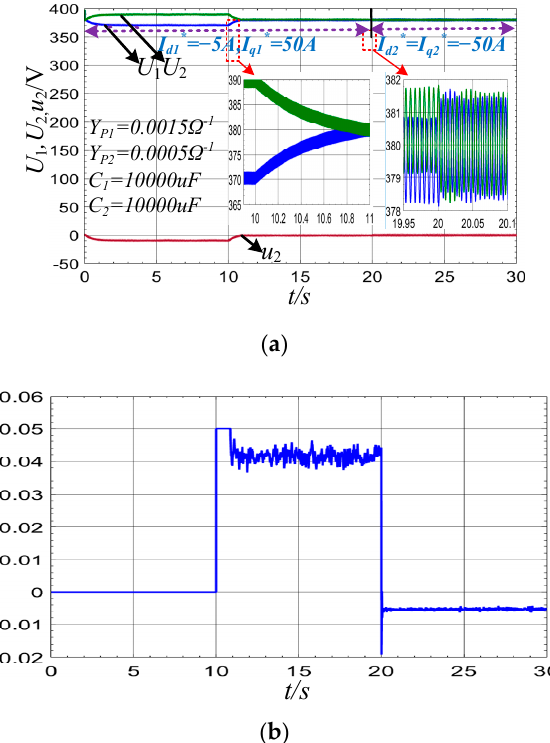
Figure 12. Waveforms when considering the amplitude of I vd . ( a ) DC voltages. ( b ) The instruction value s 0